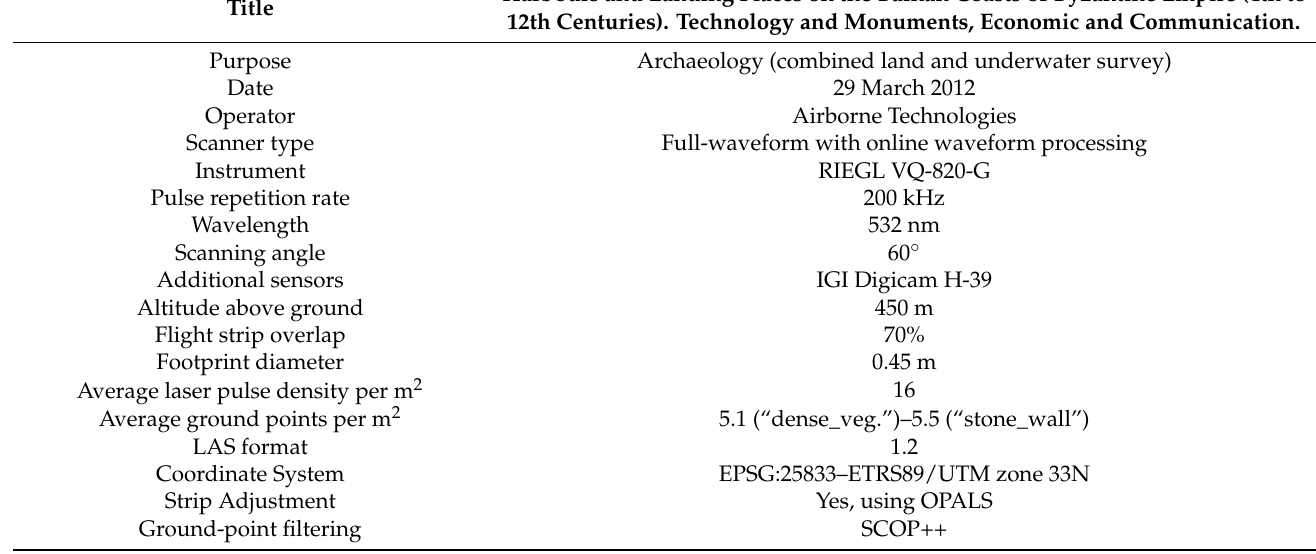
Table 1. Parameters of ALS data acquisition and processing. Harbours and Landing Places on the Balkan Coasts of Byzantine Empire (4th to 12th Centuries). Technology and Monuments, Economic and